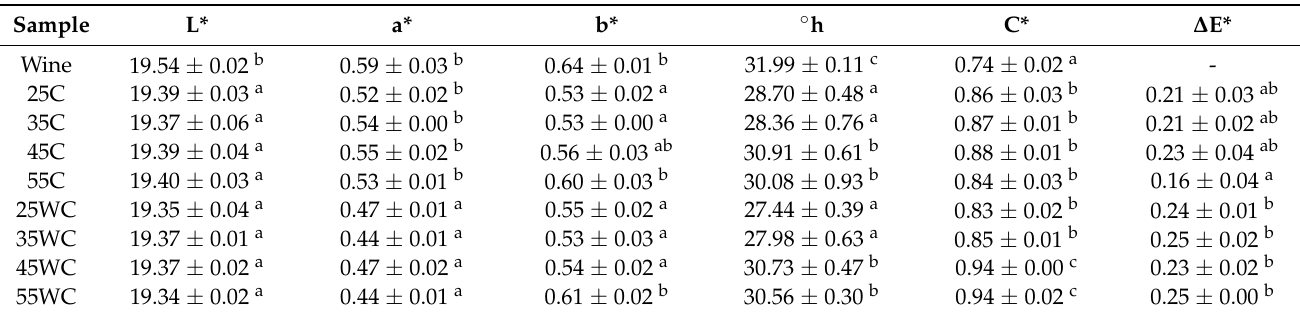
Table 9. Color parameters (L*, a*, b*, ◦ h and C*) in the initial Cabernet Sauvignon wine and retentates obtained by nanofiltration at 25, 35, 45, and 55 bar, with cooling (C) and without cooling (WC).